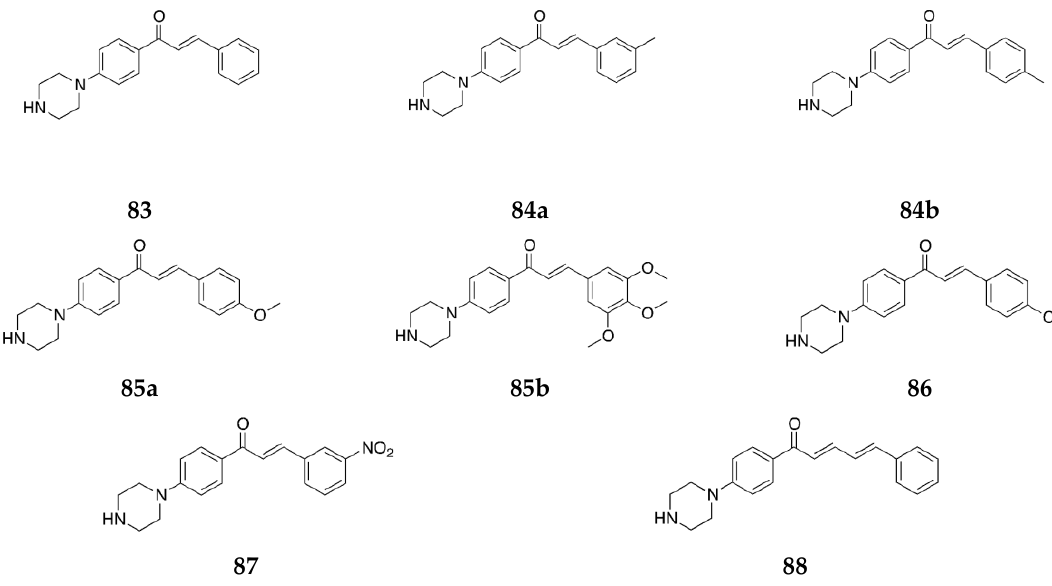
Figure 43. Chemical structures of N,N -dialkylated 4-aminochalcone derivatives.